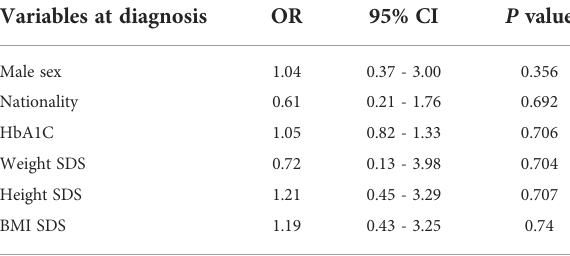
TABLE 4 Predictive factors, using multiple logistic regression analysis, of presenting with severe DKA in patients older than 6 years of age at diagnosis of